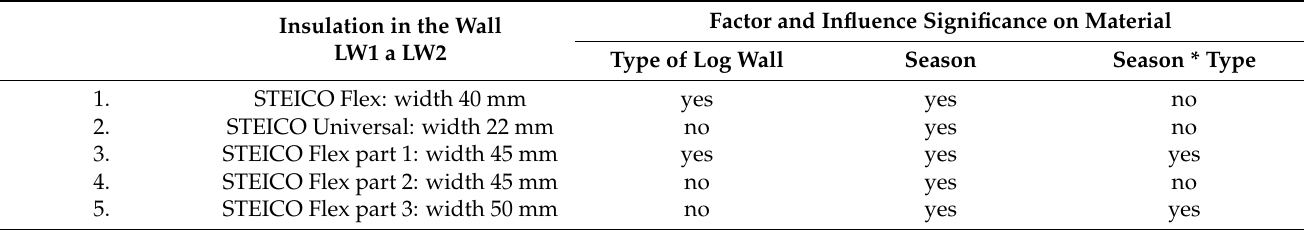
Figure 16. 95% Confidence Intervals for Mean Moisture Contests of STEICO Flex part 3. Statistical analysis of factor analyzed influence on insulation moisture content was done in STATISTICA ® software, results shown in Table 7. Table 7. Significance Influence (yes/no) of Analyzed Factors and Interactions on the Insulation Moisture